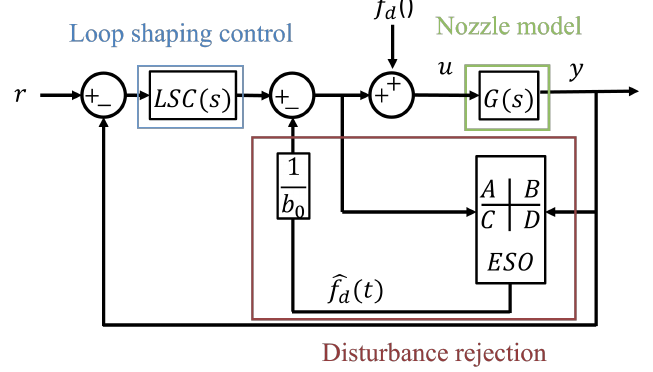
Figure 8. Combination of a Loop Shaping Control LSC with the disturbance rejection element of the LADRC